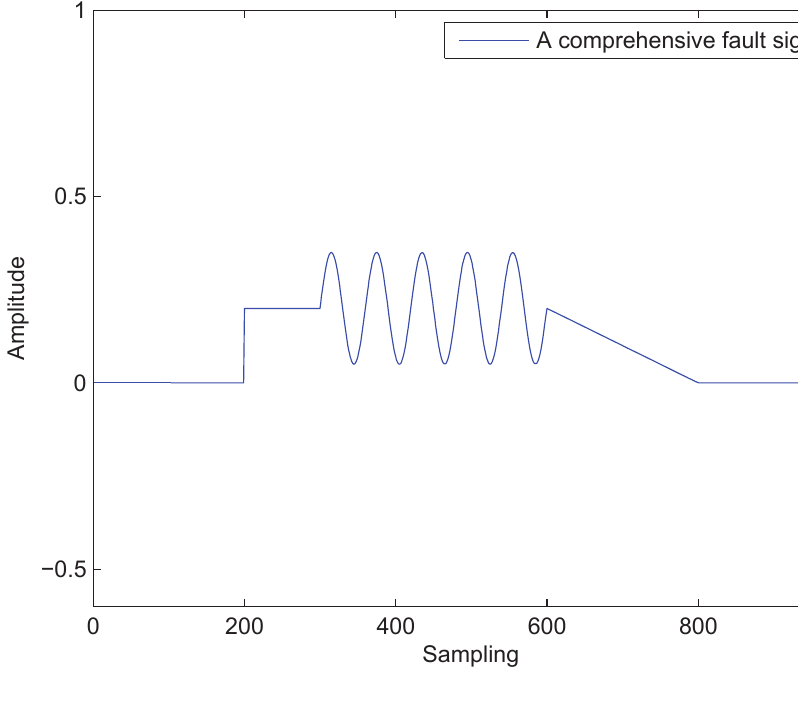
Figure 7. The fault signal.